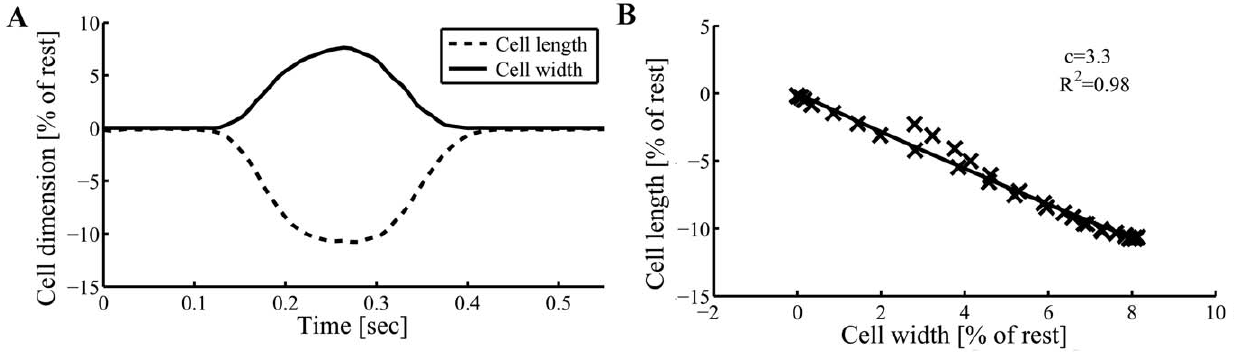
Figure 6. Cell length-width relationship during cardiomyocyte contraction-relaxation cycle. (A) The percent change in the cell-length and cell-width vs. time during a single contraction cycle. (B) The measured relationship between percent change in cell-length vs. percent change in cell-width. c is the coefficient of anisotropy (ratio of deformation magnitude between the width-y and thick-z axes). Data shown is from a representative single cardiomyocyte experiment.